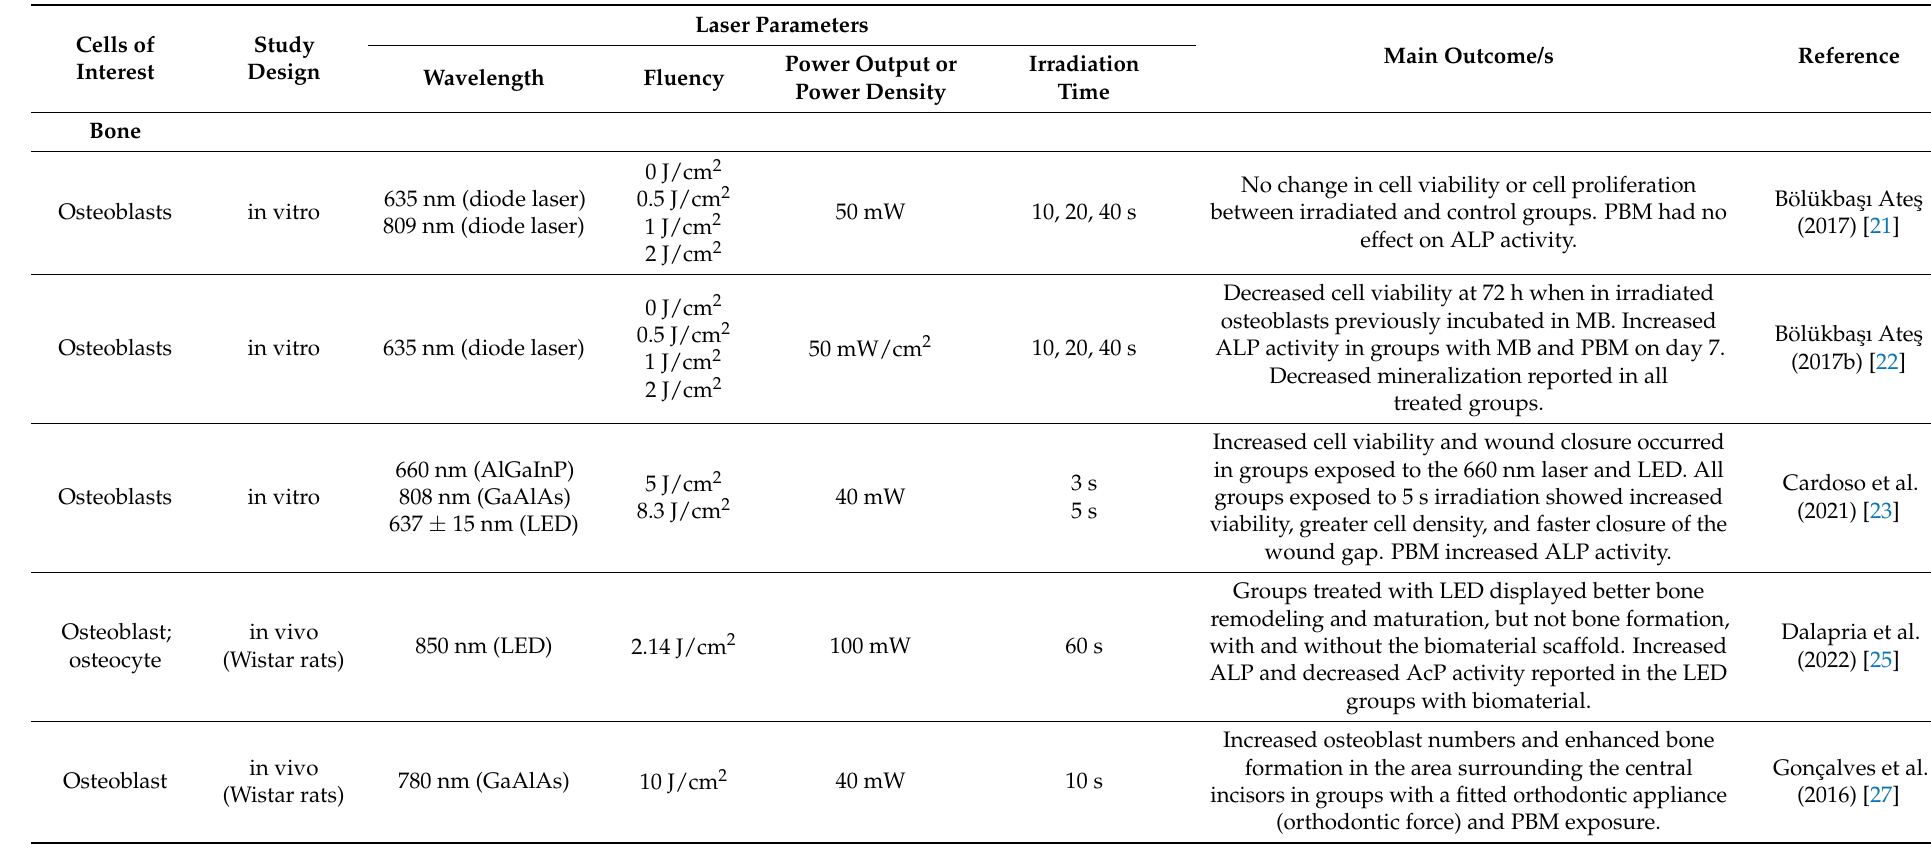
Table 1. An overview of the in vitro and in vivo studies included in this review. AcP—acid phosphatase; AIGaInP—aluminum gallium indium phosphide; ALP— alkaline phosphatase; COL—collagen; GaAIAs—gallium–aluminum–arsenide semiconductor; h—hours; HSP70—heat shock protein 70; IL—interleukin; J/cm 2 —joules per centimeter squared; LED—light-emitting diode; MB—methylene blue; miR-503—miRNA-503; min—minutes; MMP—matrix metalloproteinases;